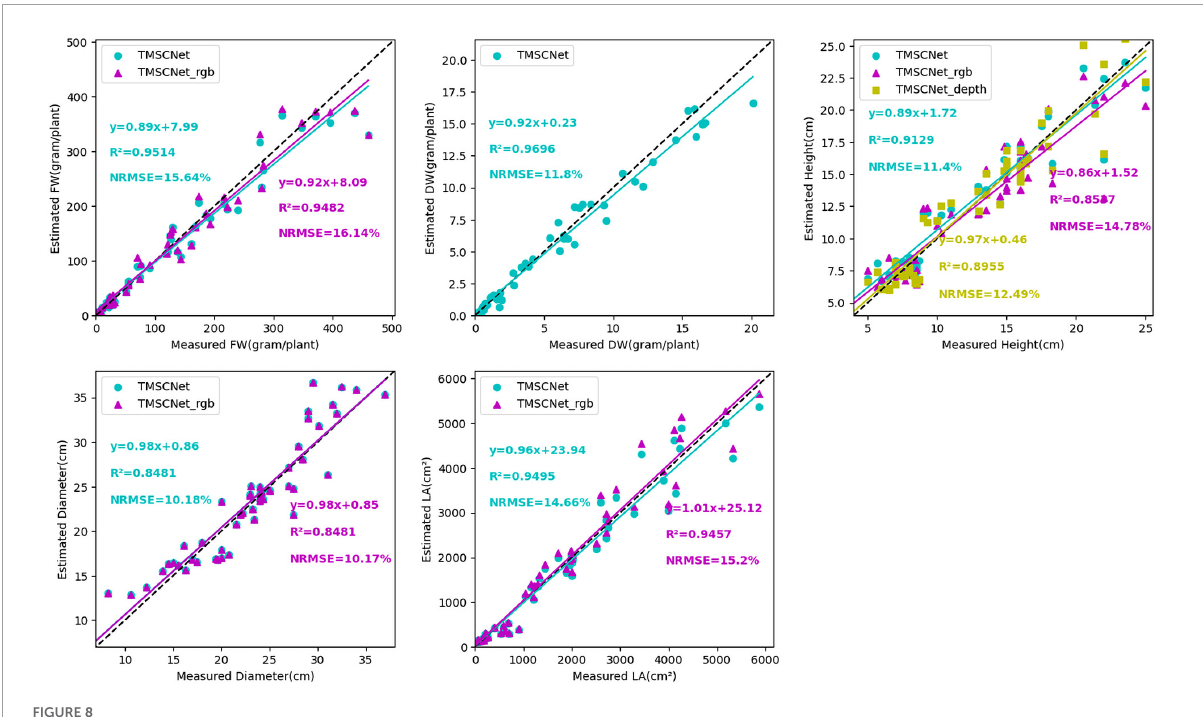
FIGURE8 Estimation result of lettuce traits based on the Model_11, Model_13, and TMSCNet.